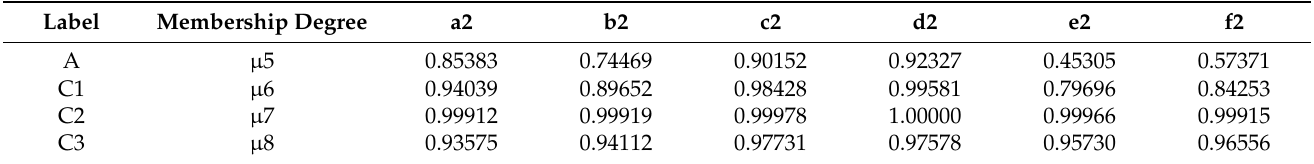
Table 12. Fuzzy set of leakage faults in speed regulating